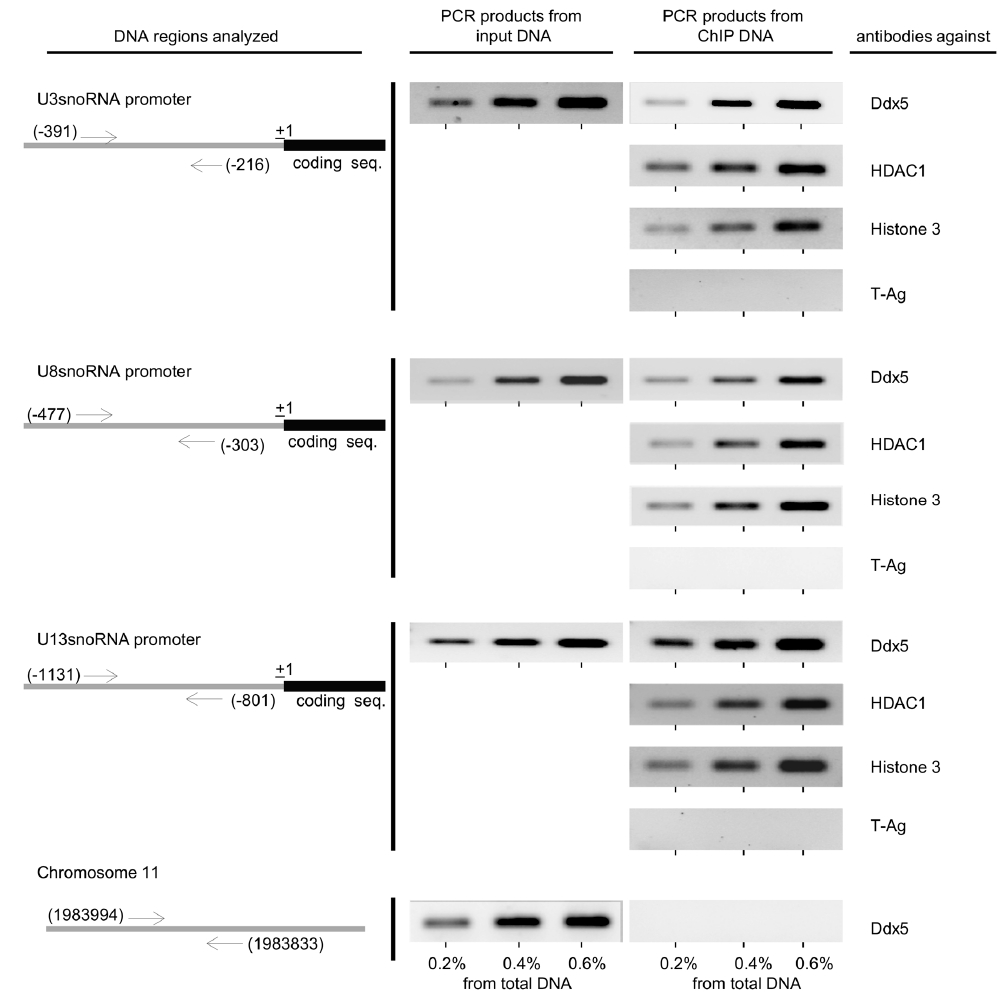
Figure 4. Binding of Ddx5 and histone deacetylase 1 (HDAC1) to the promoters of the U3-, U8-, and U13snoRNA genes in HeLa cells. The DNA regions analyzed by chromatin immunoprecipitation (ChIP) are schematically shown on the left, each bound by a pair of primers (arrows) showing the genomic location of their first nucleotide. A non-binding region of chromosome 11 (CHR11: 1,983,833 1,983,994) was used as a control. The antibodies used in the ChIP-precipitation analysis are shown on the right. As a control, a SV40 T-antigen-specific antibody (PAb101) was used (T-Ag). The immunoprecipitated DNA was analyzed semi-quantitatively in comparison to indicated amounts of input